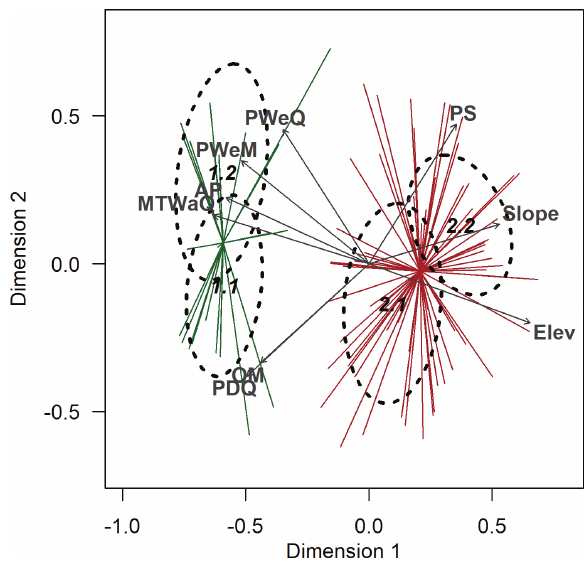
Figure 4. Isometric feature mapping plot (ISOMAP), based on Bray-Curtis dissimilarity of 92 relevés × 601 plant species matrix for those vegetation types that include Trithrinax campestris in central Argentina. Vege- tation type codes: 1.1 Celtis tala / Sida rhombifolia closed forest; 1.2 Aspidosperma quebracho-blanco / Prosopis kuntzei open forest; 2.1 Jarava pseudoichu / Vachellia caven open savanna; 2.2 Acalypha variabilis / Nassella cordobensis scrubland. Environmental variables